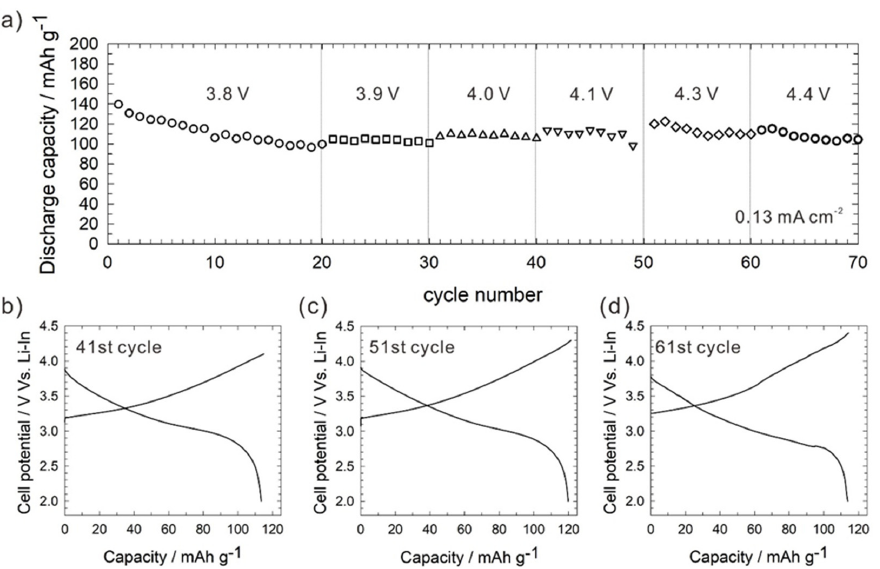
Figure 8. ( a ) Cycle performance of the all-solid-state cells using composite electrodes with LPSCl SEs prepared via solution process, at charge-end voltages from 3.8 to 4.4 V vs. Li–In alloy (4.4 to 5 V vs. Li). ( b – d ) Charge–discharge curves performed with charge-end voltages of 4.1, 4.3, and 4.4 V,